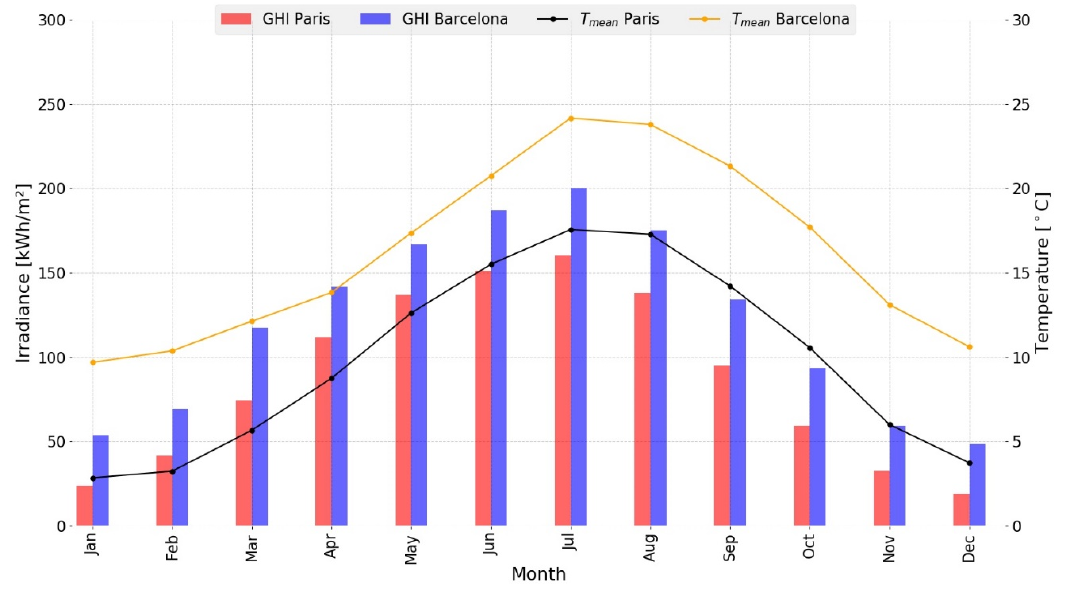
Figure 5. Monthly irradiances and mean temperatures for Barcelona and Paris.